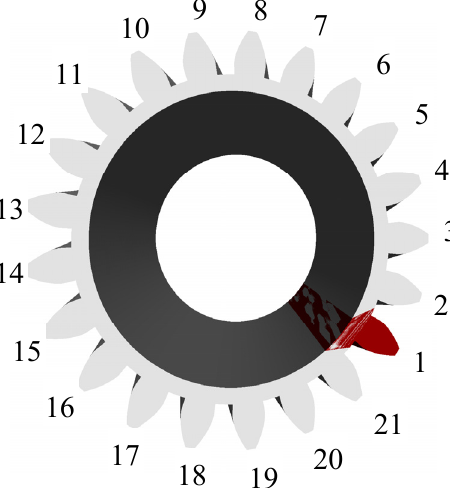
Figure 19. Front view of the sun gear in the SIMPACK model.